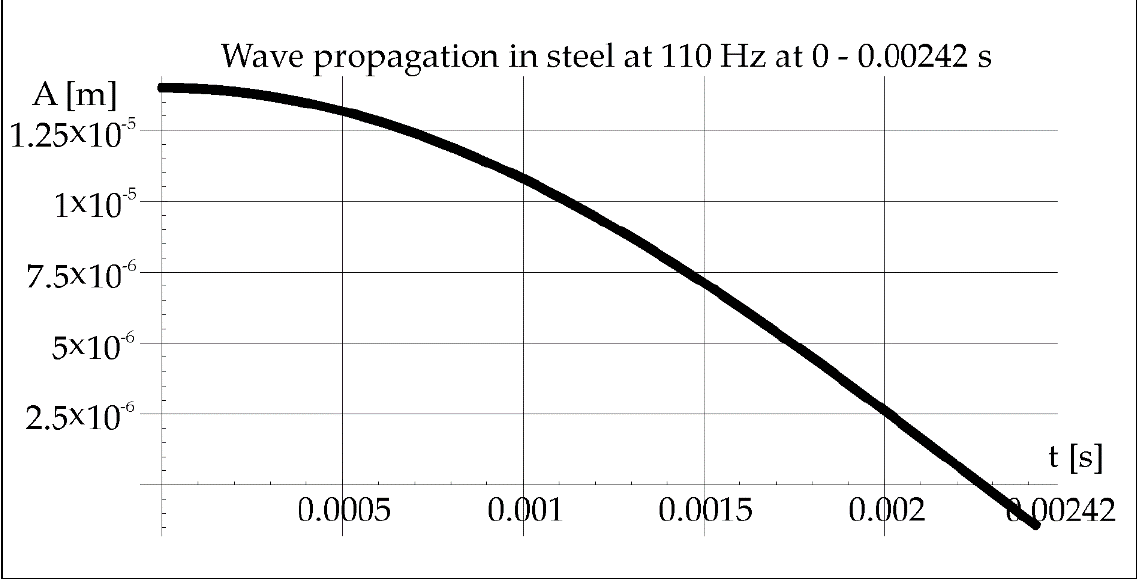
Figure 10. Propagation of acoustic wave in steel at 110 Hz during 0–0.00242 s.